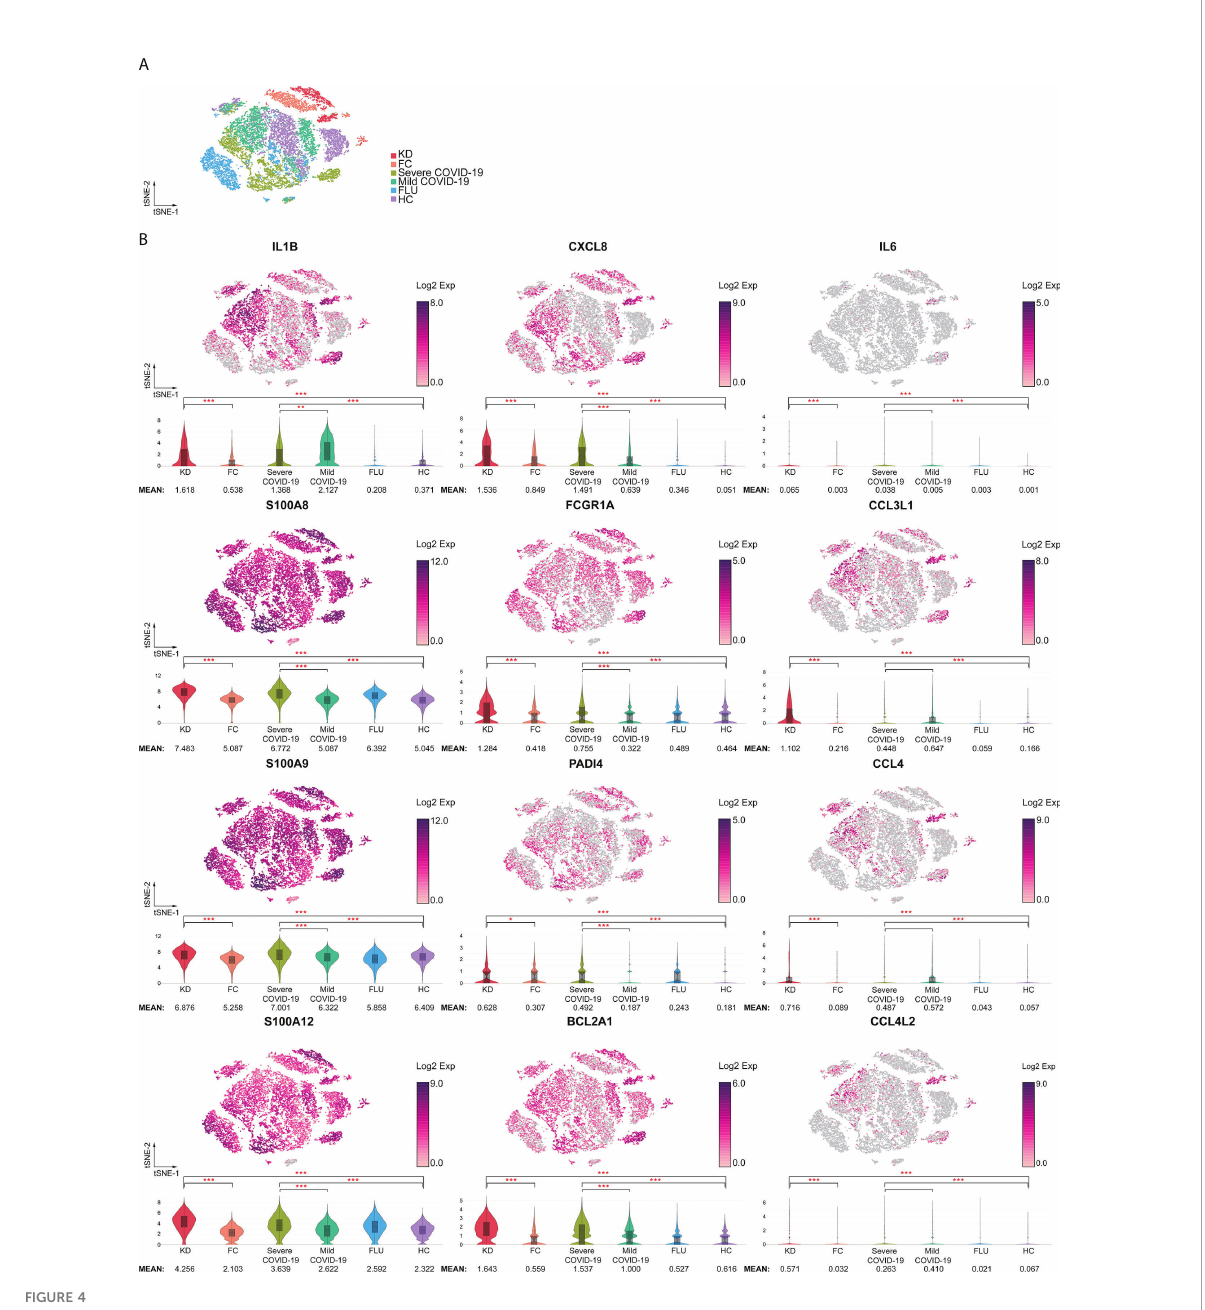
FIGURE 4 Increased activation signatures in neutrophils from both KD and severe COVID-19 patients. (A) t-SNE projection of neutrophils across disease conditions. (B) t-SNE and violin plots of normalized log2 expression levels of activation genes in cluster 1 identi fi ed in Figure 3A. The panel of genes was chosen based on their known role in neutrophil activation (IL1B, IL6, CXCL8, S100A8, S100A9, and S100A12), in fi ltration (CCL3L1, CCL4, CCL4L2, and FCGR1A), survival (BCL2A1), and neutrophil extracellular trap formation (PADI4). < 0.05 (*), < 0.005 (**) or < 0.0005